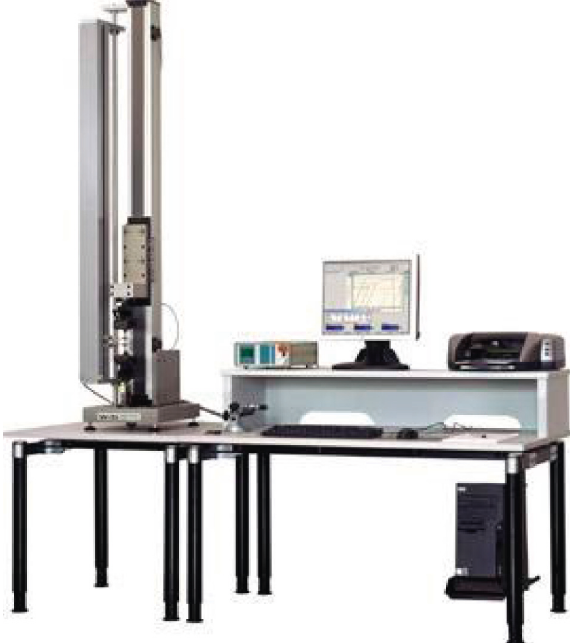
Figure 8: Multipurpose microtensile testing machine.